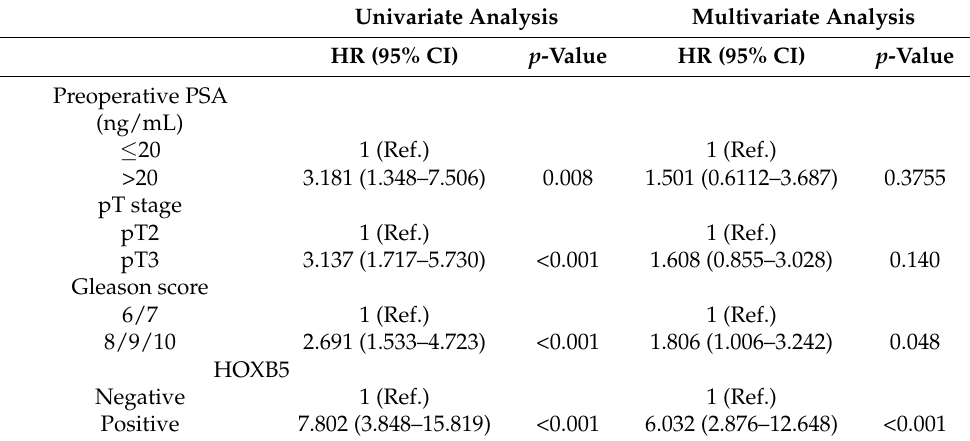
Table 2. Univariate and multivariate Cox regression analysis of PSA recurrence-free